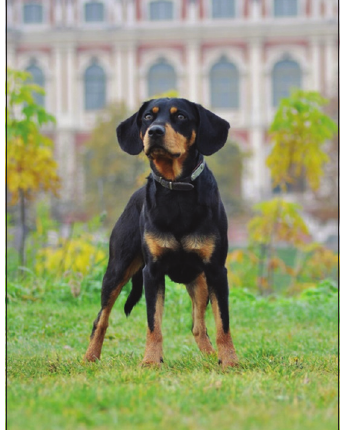
Figure-1: Latvian Hunting